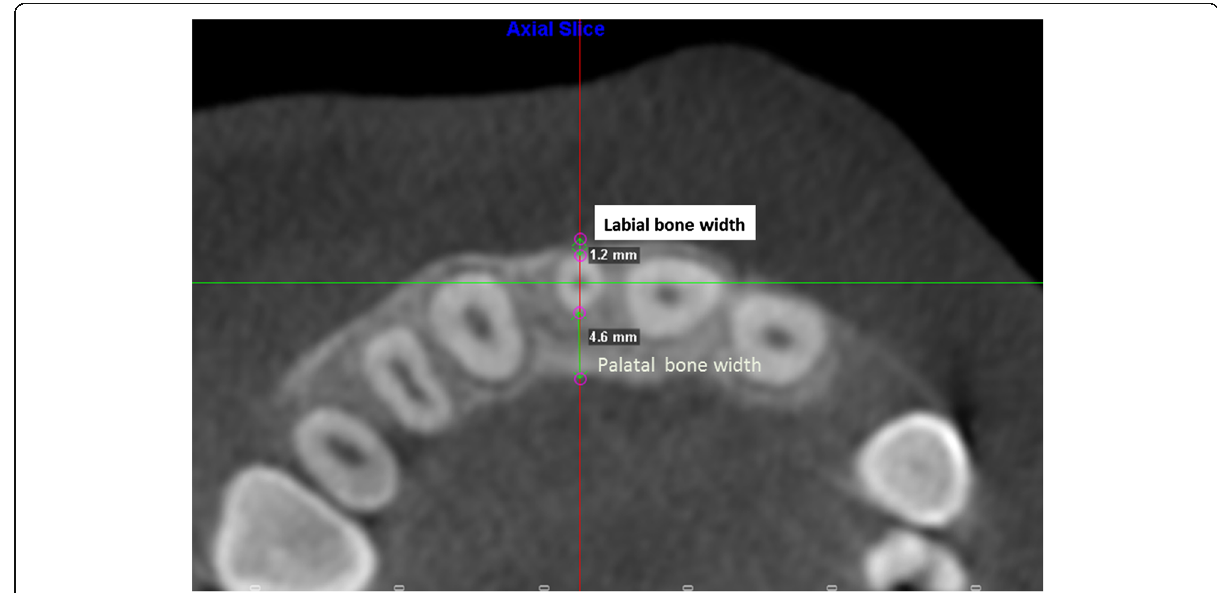
Fig. 5 Labial and palatal bone width on axial slice 6 mm apical to